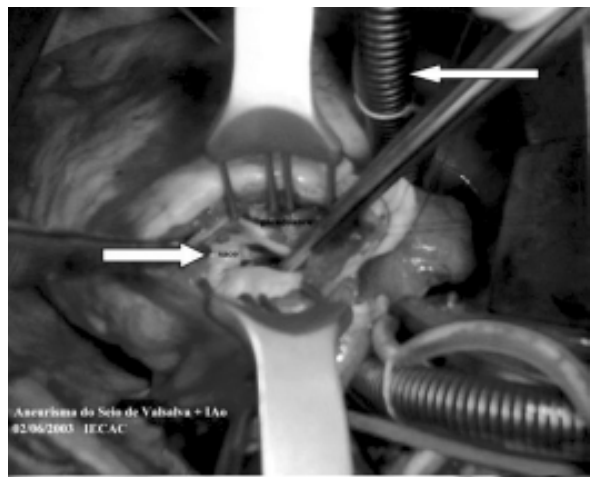
Fig. 4 - Aorta aberta, na fase final da plastia da valva aórtica pela técnica de Trusler, indicada pela seta superior esquerda e aorta ascendente e veia cava superior, pela seta inferior